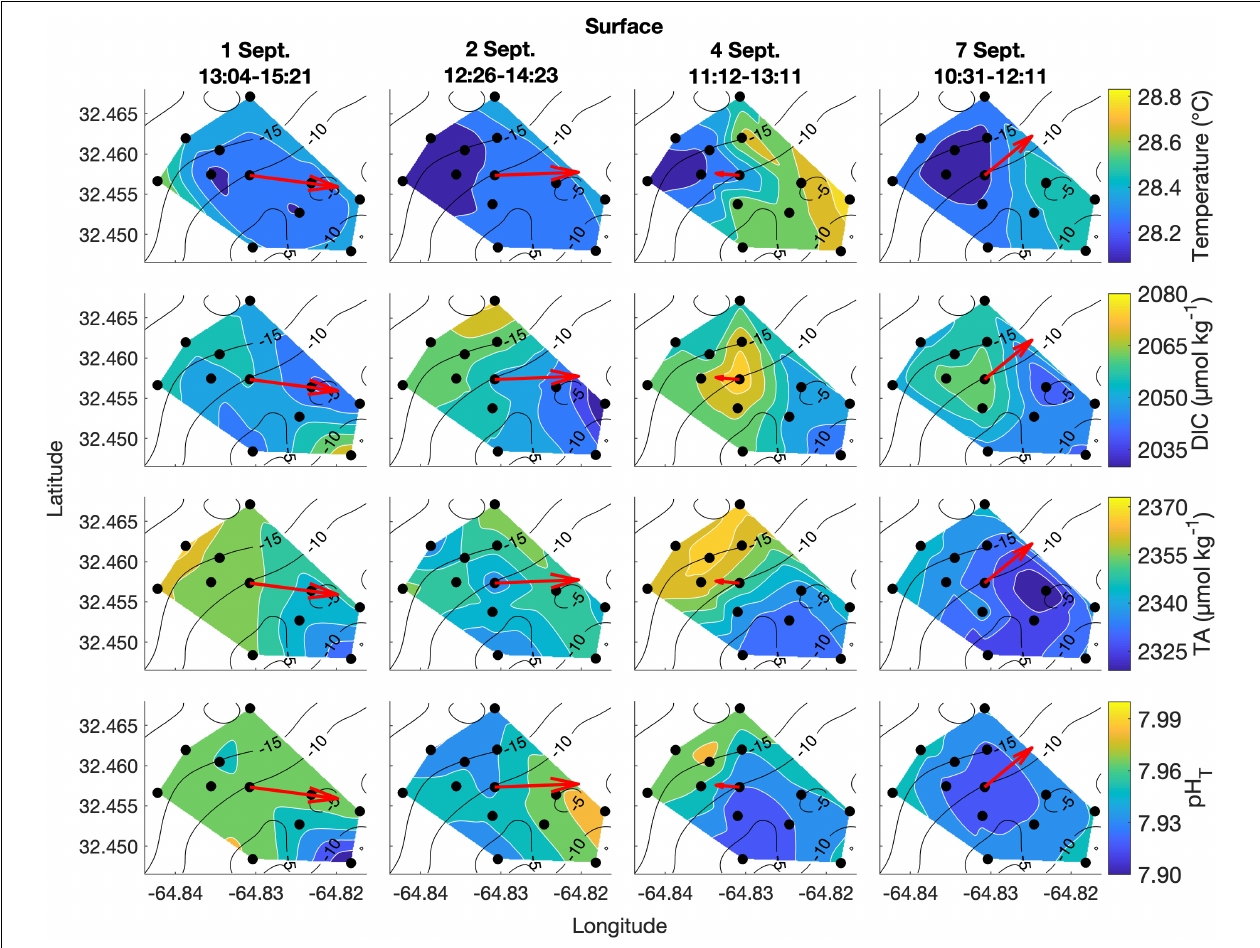
FIGURE 4 | Lateral spatiotemporal variability at the surface in temperature, DIC, TA, and pH T (calculated from measured DIC and TA) on September 1, 2, 4, and 7. Plots also contain bathymetry contours (black) and the mean depth-averaged velocity vector averaged over the sampling period